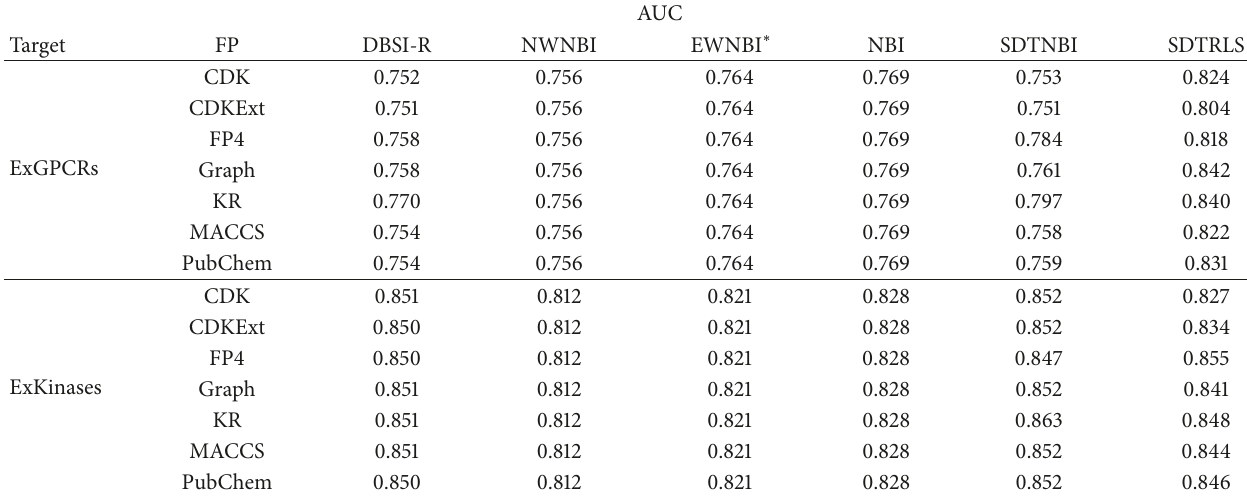
Table 4: The performance of two external